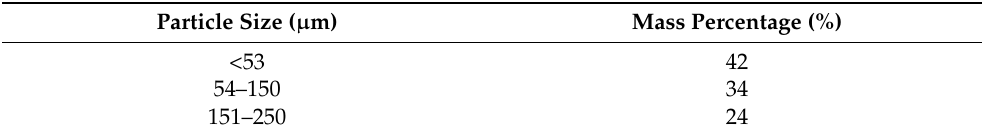
Table 5. Mass percentage composition as a function of the particle size of the ground NdFeB magnet powder obtained from